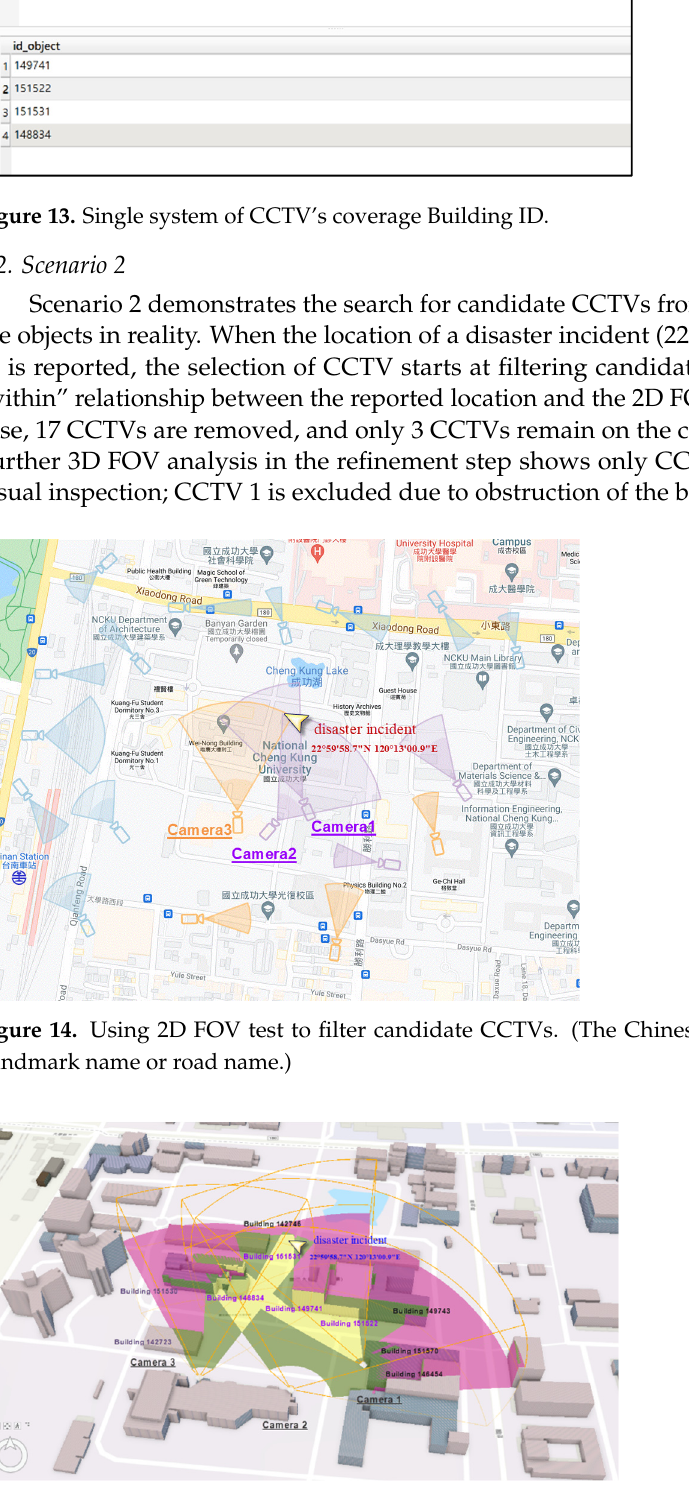
Figure 15. 3D FOV analysis for scenario 2.